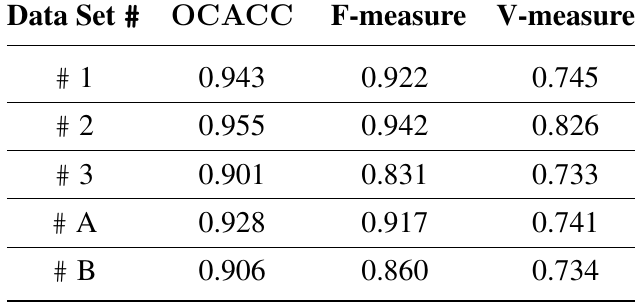
Table 8. Classification results evaluated using three different metrics. For the calculation of V-measure the value β = 1 is